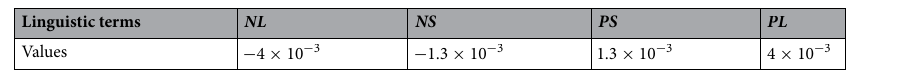
Table 1. The reference values and points of the zero-order term drift coefficient.